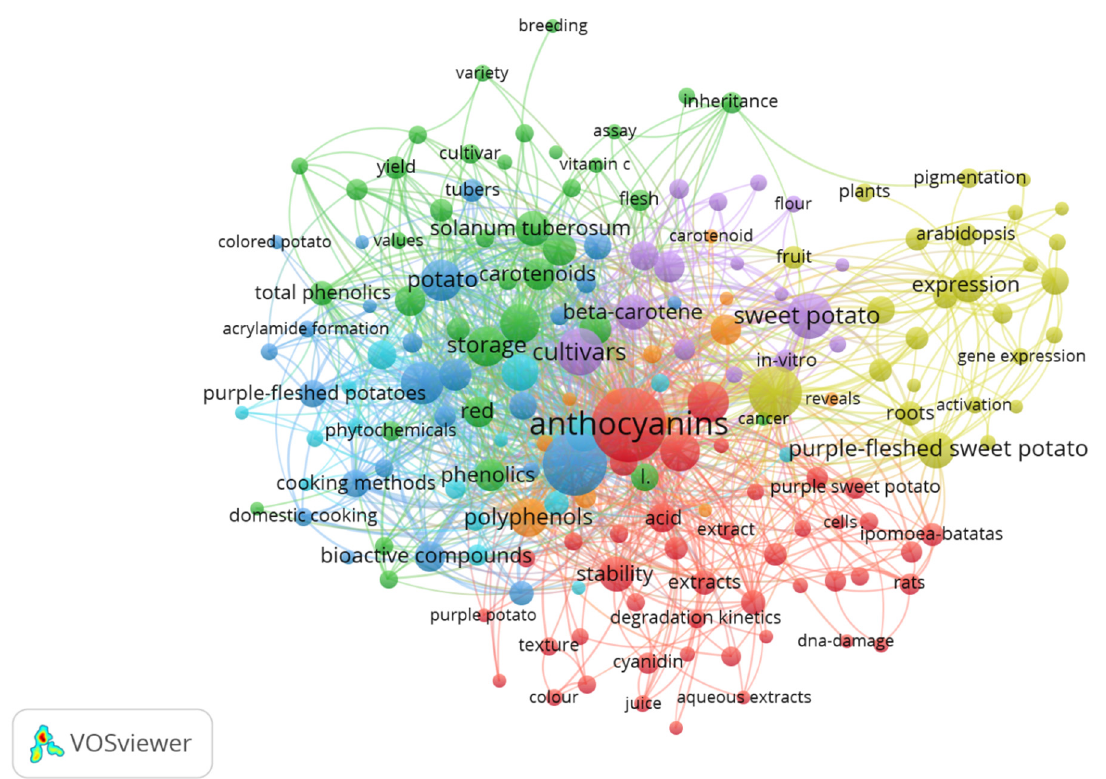
Figure 6. Graphic representation of cooccurrence of all keywords collected from 408 scientific papers with the PFP as a general subject of study. Own processed data on VOSviewer, version 1.6.15 [33.]